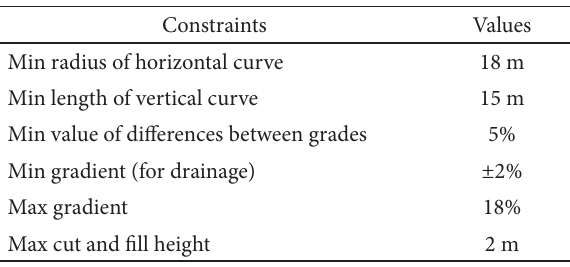
Table 1. Primary road design constraints for road design application